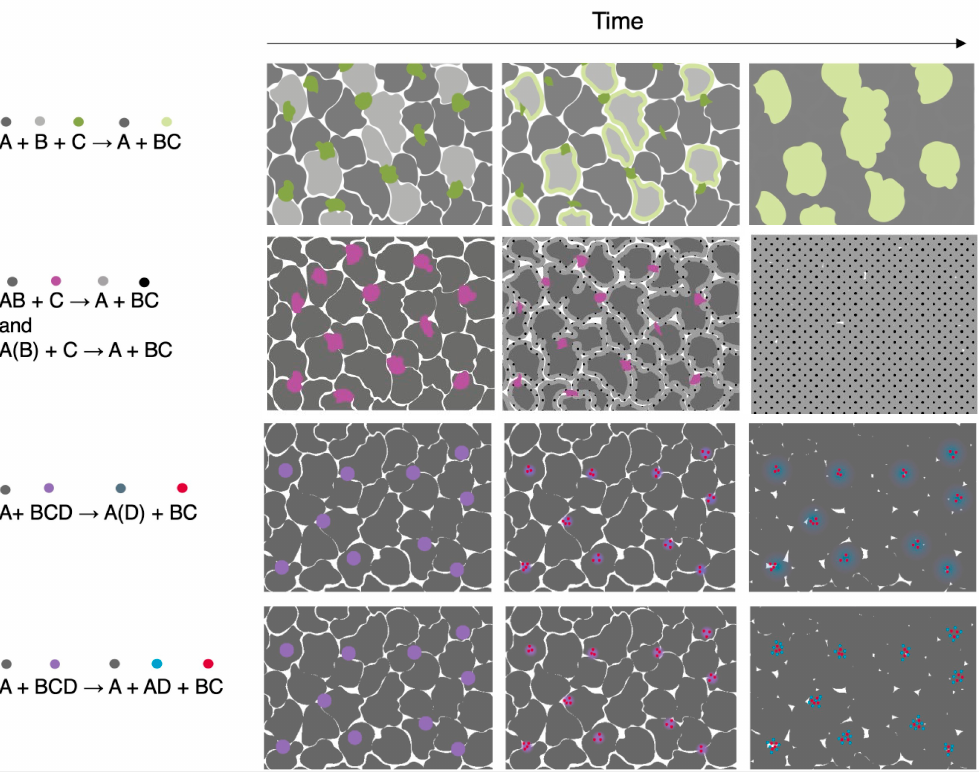
Figure 7. Microstructural evolution of raw material possibilities for composites of type A + BC. The pictures in the first column correspond to the beginning of the reaction (t = 0), the second column to an intermediate state of the process, and the third column to the system’s final state.